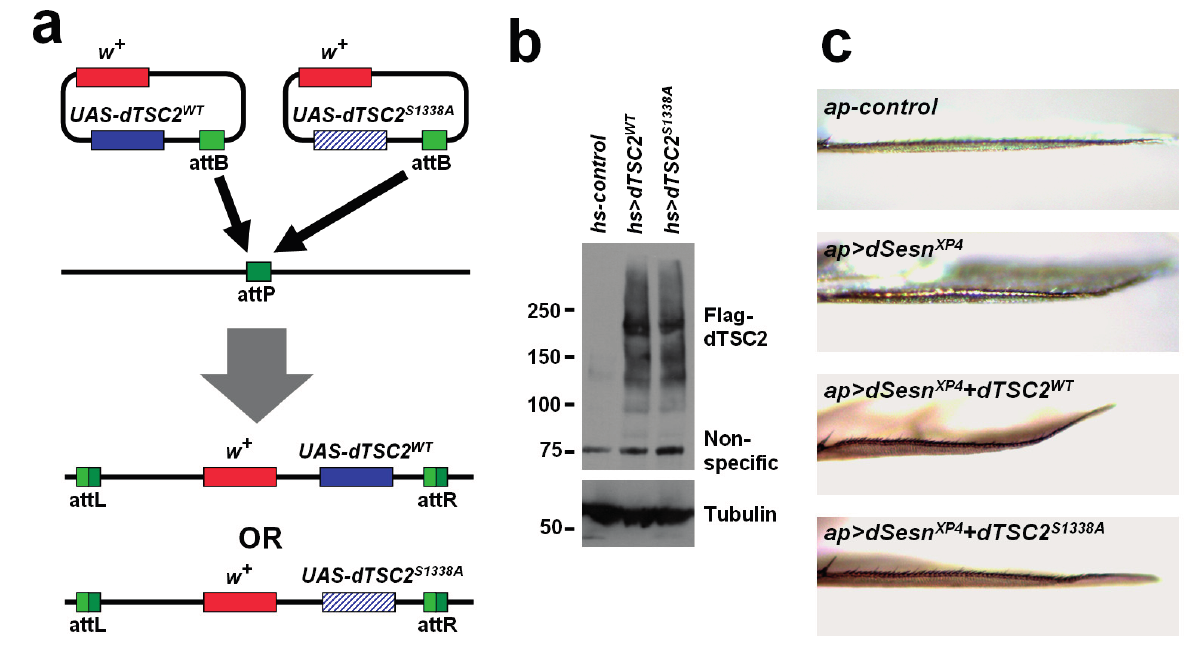
Figure 4. Ser1338 is required for genetic interaction between Drosophila TSC2 and Sestrin. ( a ) Schematic representation of how Drosophila TSC2 transgenic flies were made. Plasmid which can express wild-type or Ser1338Ala-mutated Drosophila TSC2 was inserted into an identical genomic location (the attP site) through phiC31-mediated recombination; ( b ) Heat shock (hs) Gal4-mediated induction of Drosophila TSC2 proteins. Adult flies of indicated genotypes were incubated overnight at 30 °C and subjected to immunoblot analysis of indicated proteins. Molecular weight markers are in kDa; ( c ) Wing blades of the flies expressing indicated transgenic elements were imaged under a light dissection microscope. dSesn XP4 is an EP allele of dSesn that can drive tissue-specific Sestrin overexpression